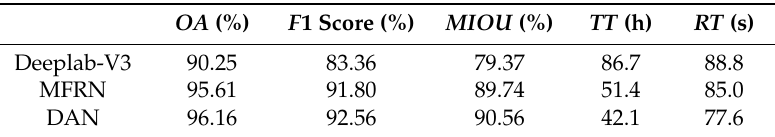
Table 4. Object-based evaluation results of the proposed network with other networks on Potsdam datasets using the completeness, C m ; correctness, C r ; quality metrics, Q ; ( C m ,2.5 , C r, 2.5 , and Q 2.5 are for buildings over 2.5 m 2 ).